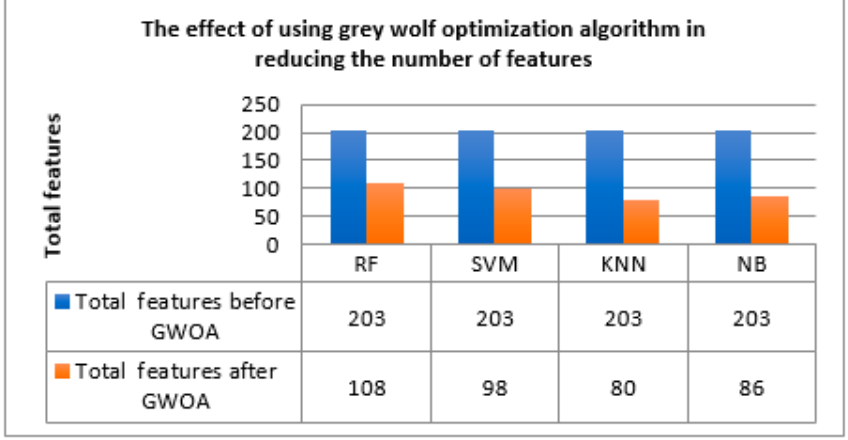
Table 6. Performance comparison of the proposed method and other machine learning classifiers .